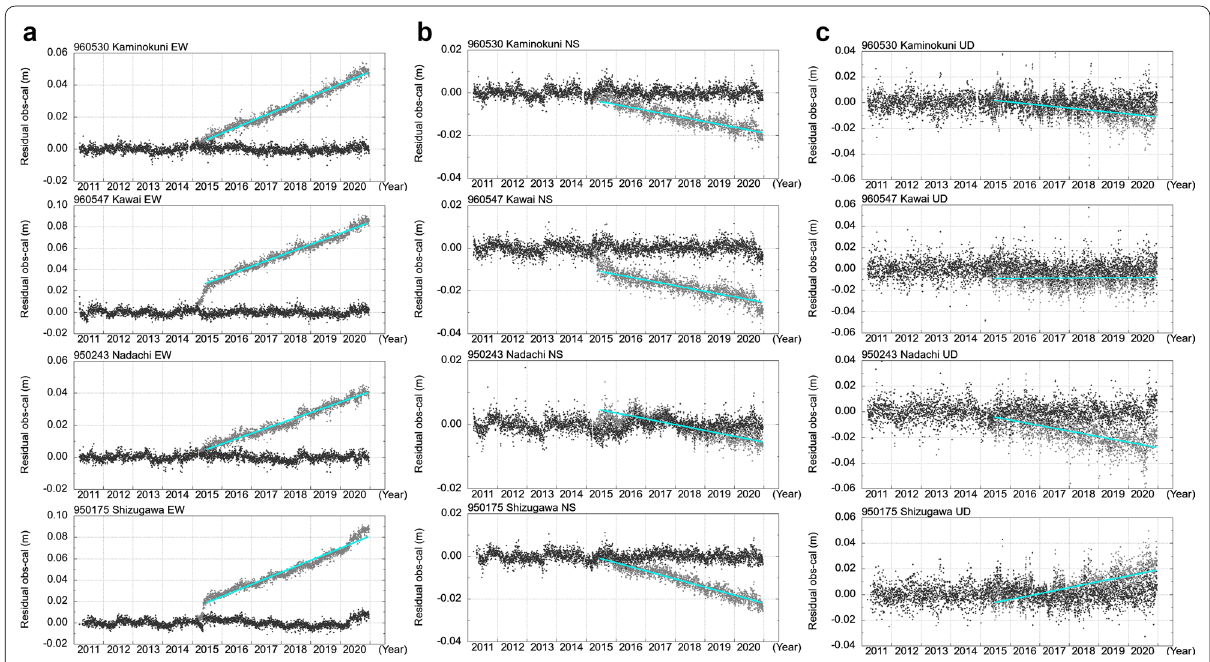
Fig. 3 Residuals between observed values and the 3.9-year model. Each component of a east–west (EW), b north–south (NS), and c up–down (UD) is drawn for the four observation stations (Figs. 1 and 2). Gray dots indicate the residuals of the 3.9-year model based on Eq. (1). Black dots represent the residuals of the predicted value by adding a linear deformation term after 2015 to a 3.9-year model based on Eqs. (3) and (4). Light blue, straight lines indicate fittings of the gray dots from December 2015 to December